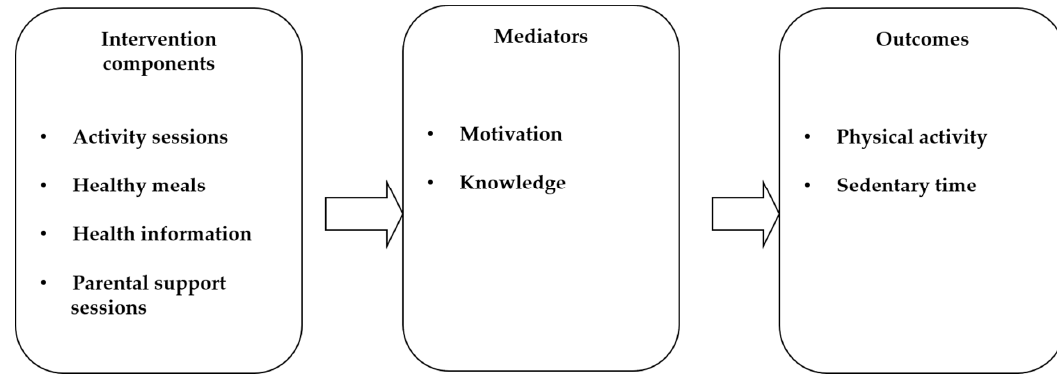
Figure 2. Logic model of the program.